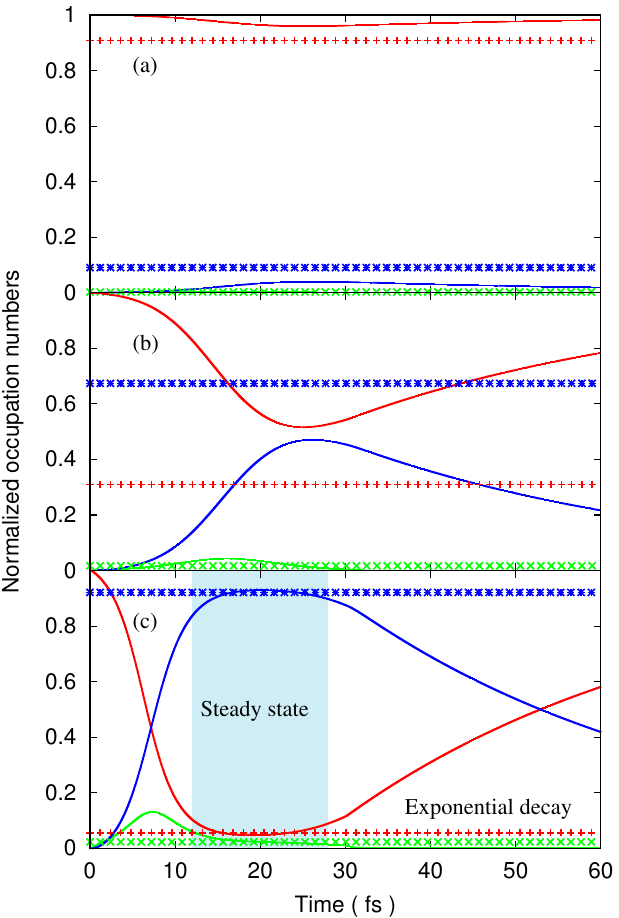
Figure 2. Time dependence of the density of occupation numbers (normalized by the total number N ) at the end face of Al thin film. The conditions are the same as in Figure 1. The fluences of incoming Gaussian pulses are 1.5, 15 and 150 J/cm 2 from the top to the bottom of three figures, respectively. The solid curves and dotted lines are estimated by the three-channel model and long pulse model, respectively. The red color indicates the ground state | 1 (cid:105) , the blue one the excited state | 2 (cid:105) and the green one the relaxed state | 3 (cid:105) . After some time, the curves asymptotically approach the steady state of the long pulse model. In the region of the light blue shade, the system has reached a steady state. After about 30 fs (the total pulse width), the excited state decays exponentially. The averaged experimental data are indicated by red points with the